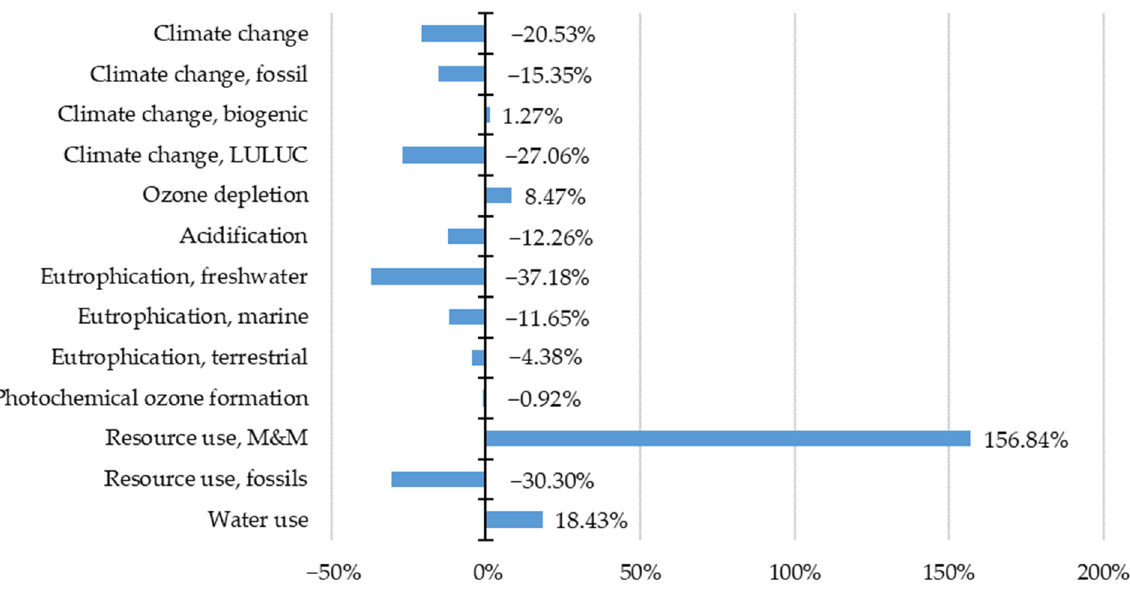
Figure 6. Total environmental impact shift considering photovoltaic energy storage.